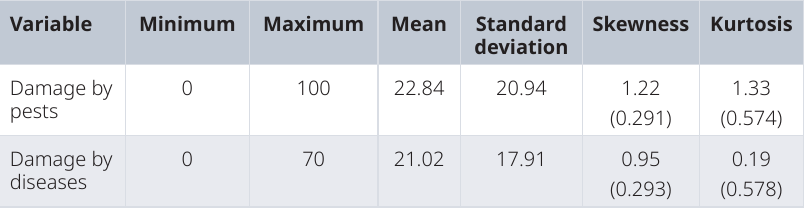
Table 5. Distribution of pests and disease